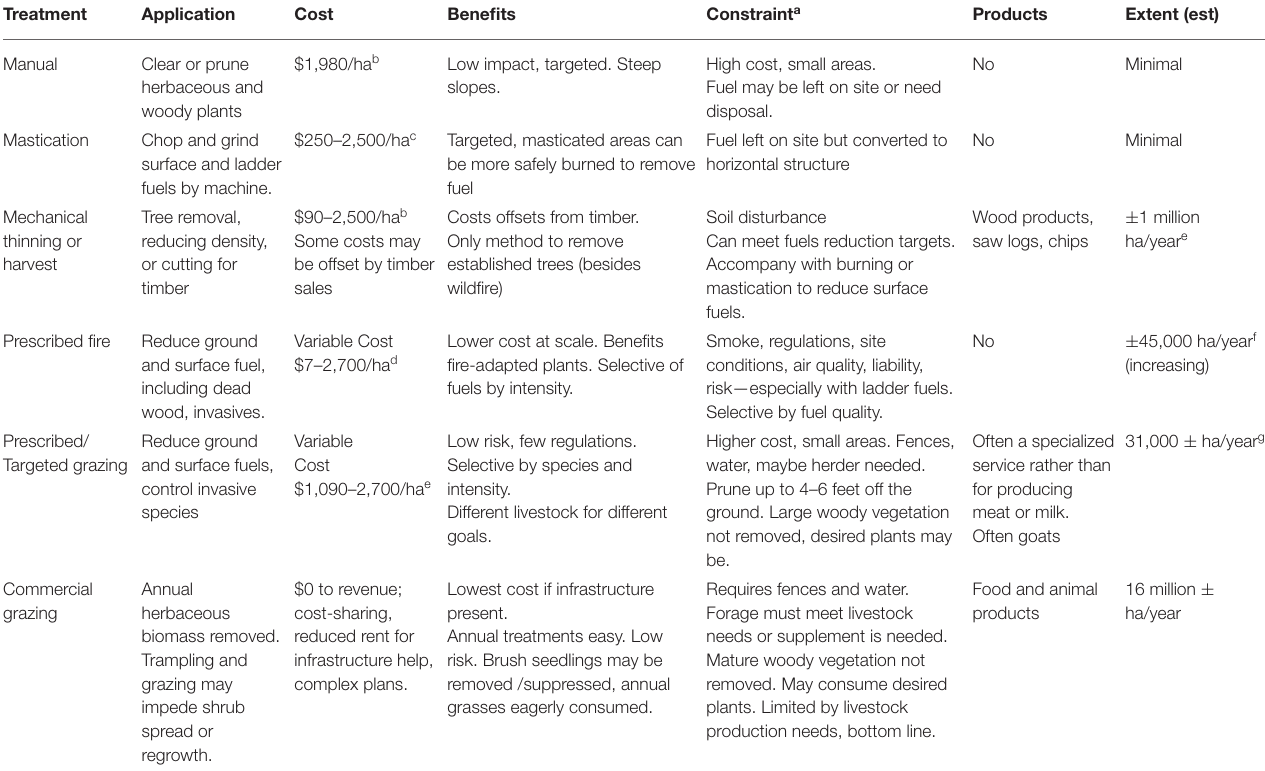
TABLE 2 | Comparison of fuel reduction treatment alternatives in